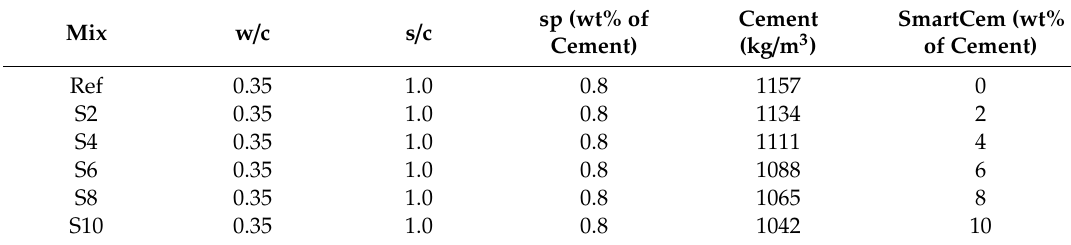
Table 2. Mix proportions used for test mortars.